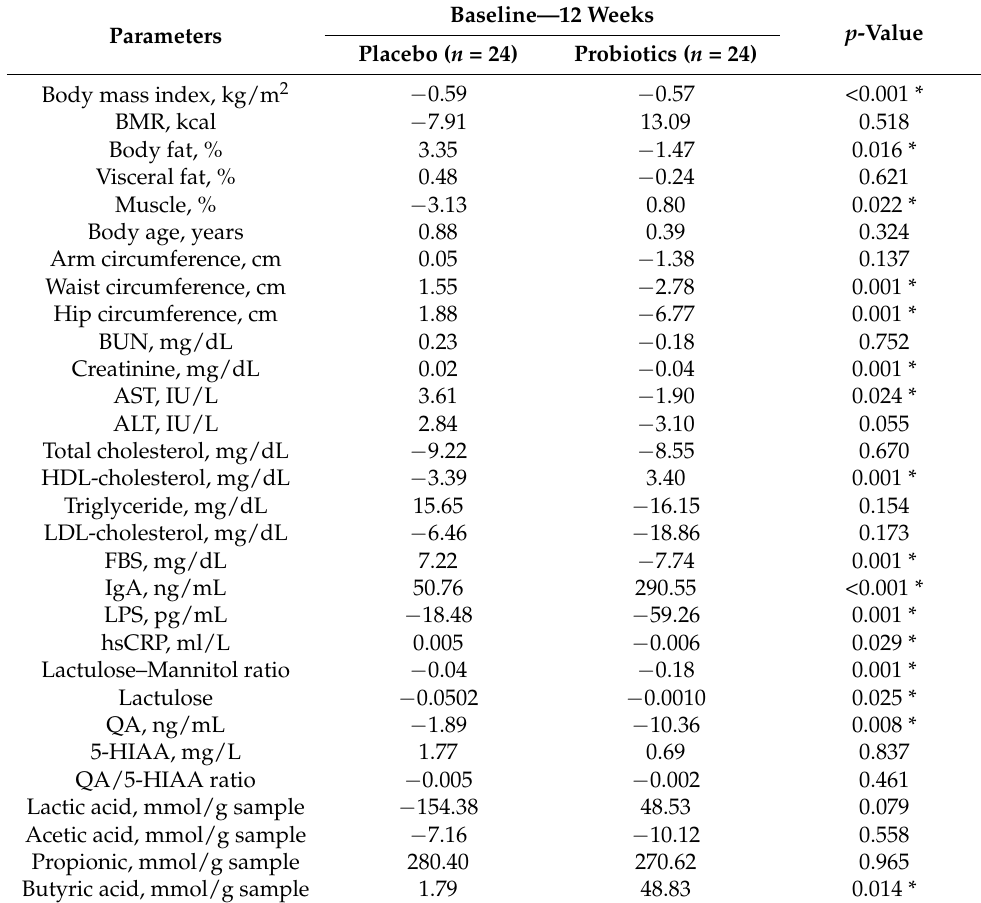
Table 3. Changes in study parameters between the group at different times, expressed as mean ±